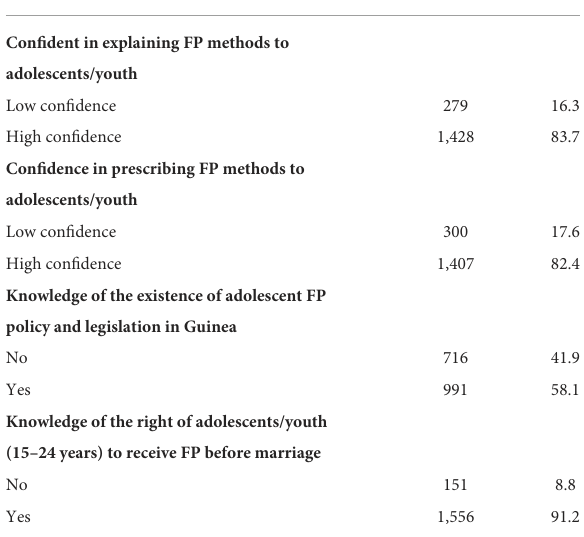
TABLE 2 Providers’ knowledge of contraceptive use among adolescents and youth, Guinea, January-March 2021 ( n = 1,707).